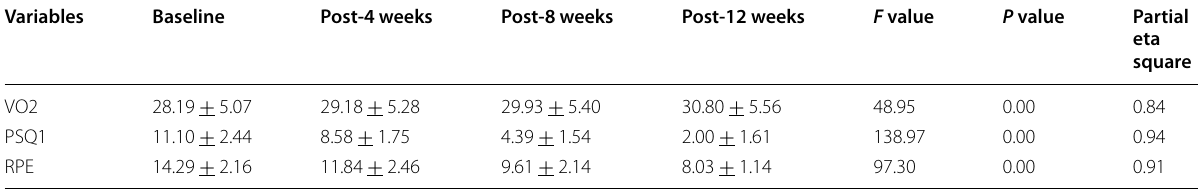
Table 2 Change in VO2, PSQI, and RPE pre- to post-intervention Variables